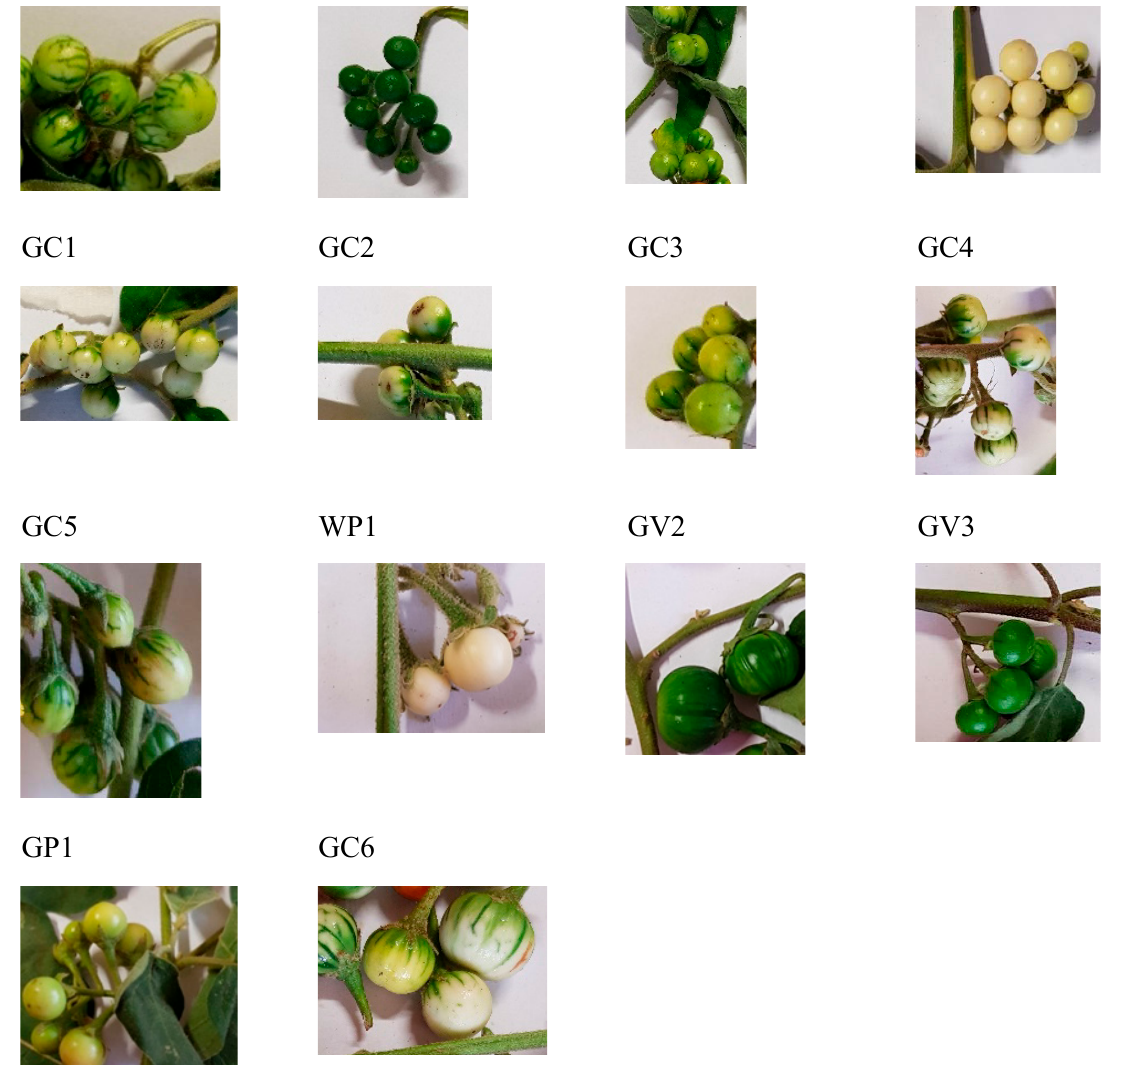
Fig. 2: Photographs of fourteen accessions of Solanum anguivi Lam. fruits. Photographs are not to scale. The accessions with one colour included LV1 (small, light green), GV1 (very small, very dark green), CP1 (small and white), WP1 (small, white), GV2 (large, dark green), and GV3 (small, dark green). Accessions with two colours included GV4 (very small, dark with light green), GC1 (small, light green with white), GC2 (small, dark green with white), GC3 (small, dark with light green), GC4 (small, light green with white), GC5 (intermediate size, dark green with cream), GP1 (small, light greenish cream) and GC6 (intermediate size, light green with